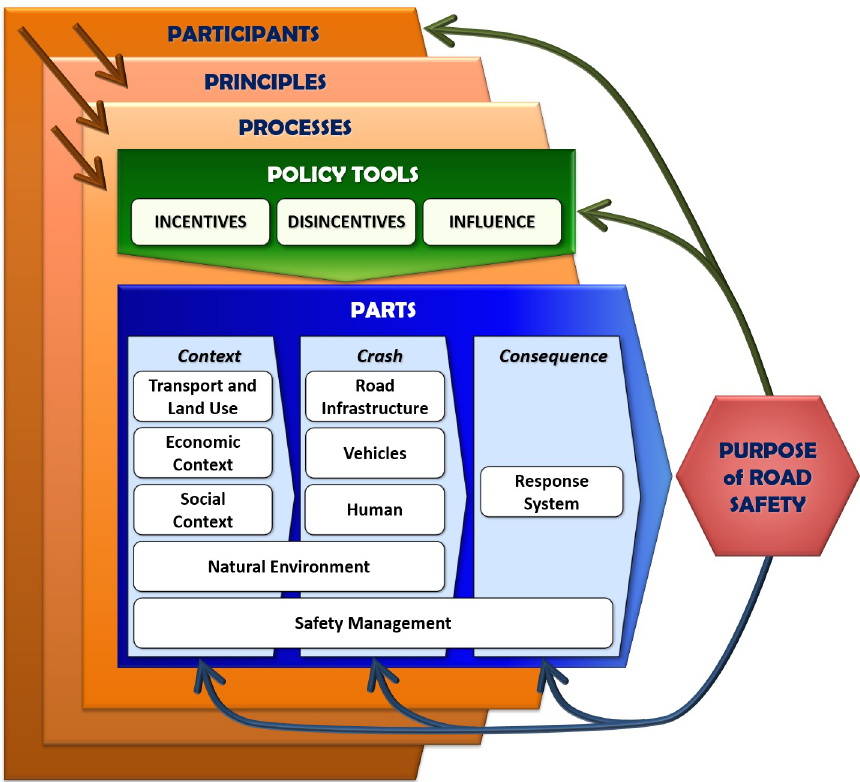
Fig 2. The 7P System framework for road safety